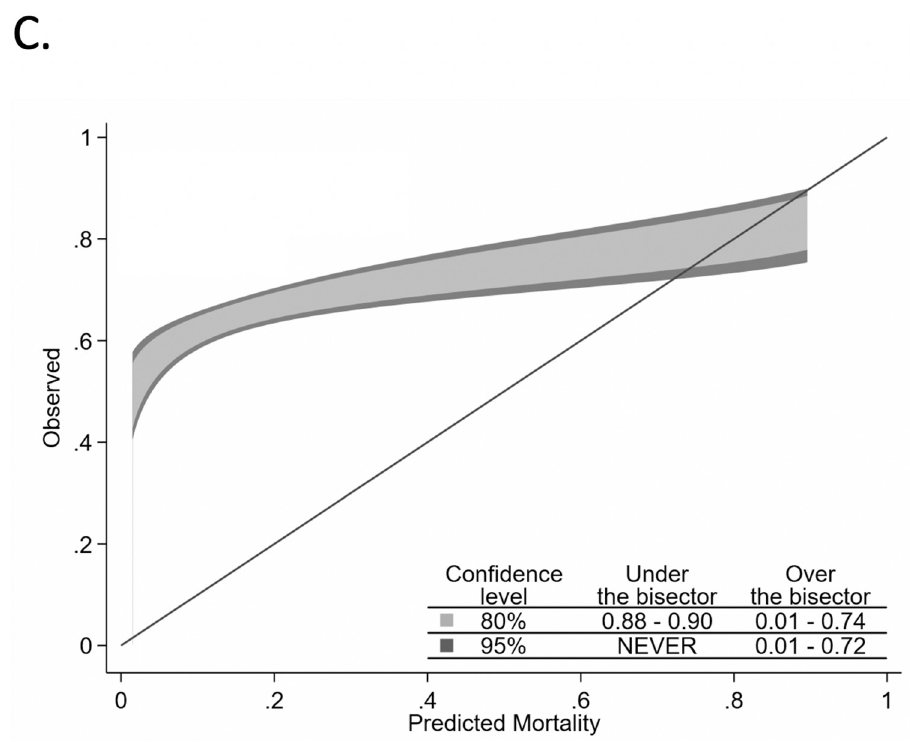
Fig 4. Comparative calibration belt plots for